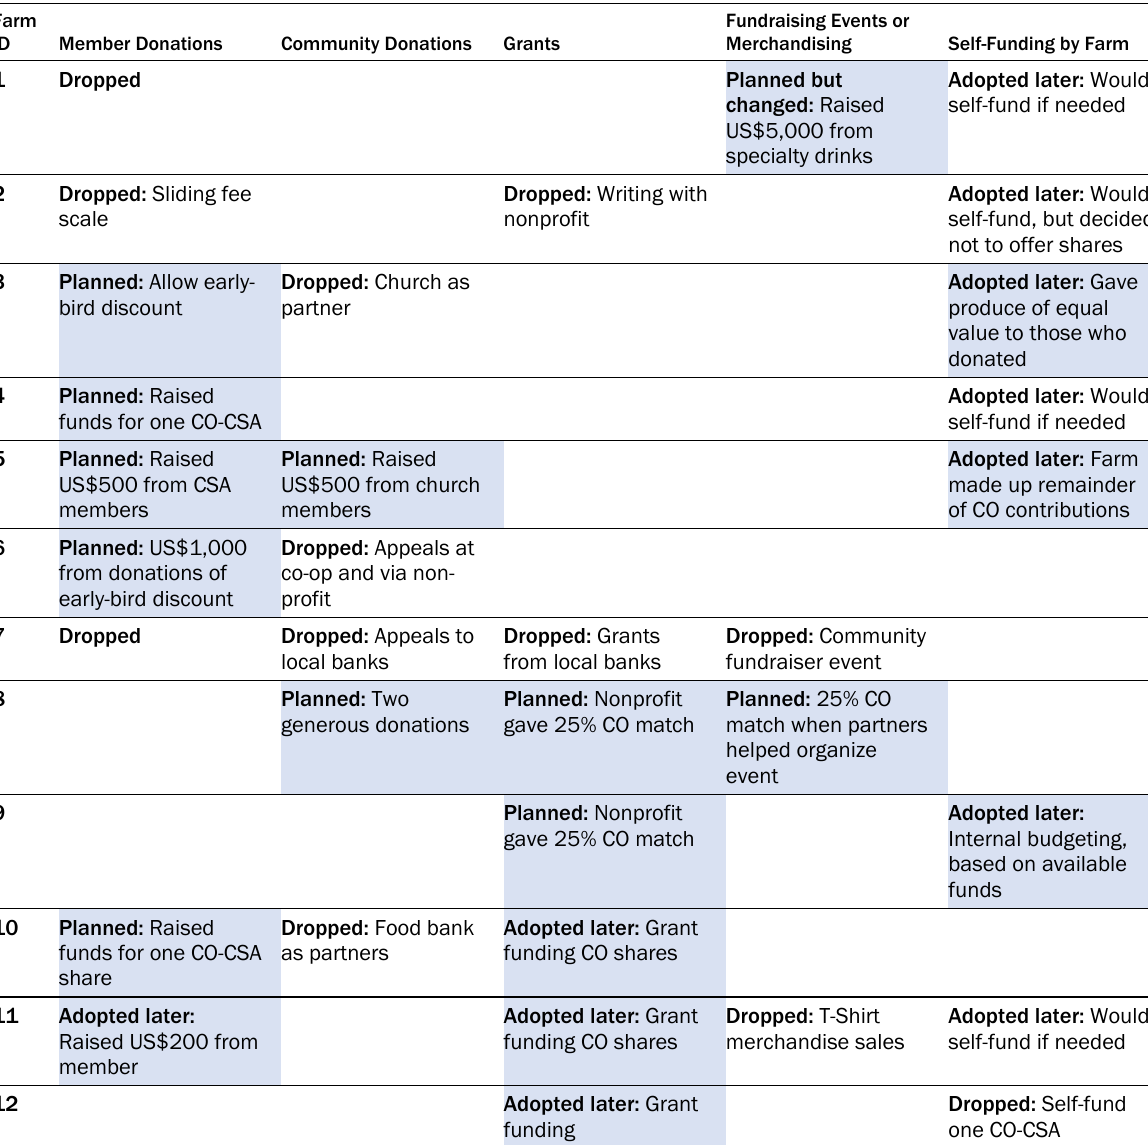
Table 1. Fresh Foods for Healthy Kids (F3HK) Farmers’ Experiences with Strategies to Fund Cost-Offset (CO) Community Supported Agriculture (CSA) Continuation